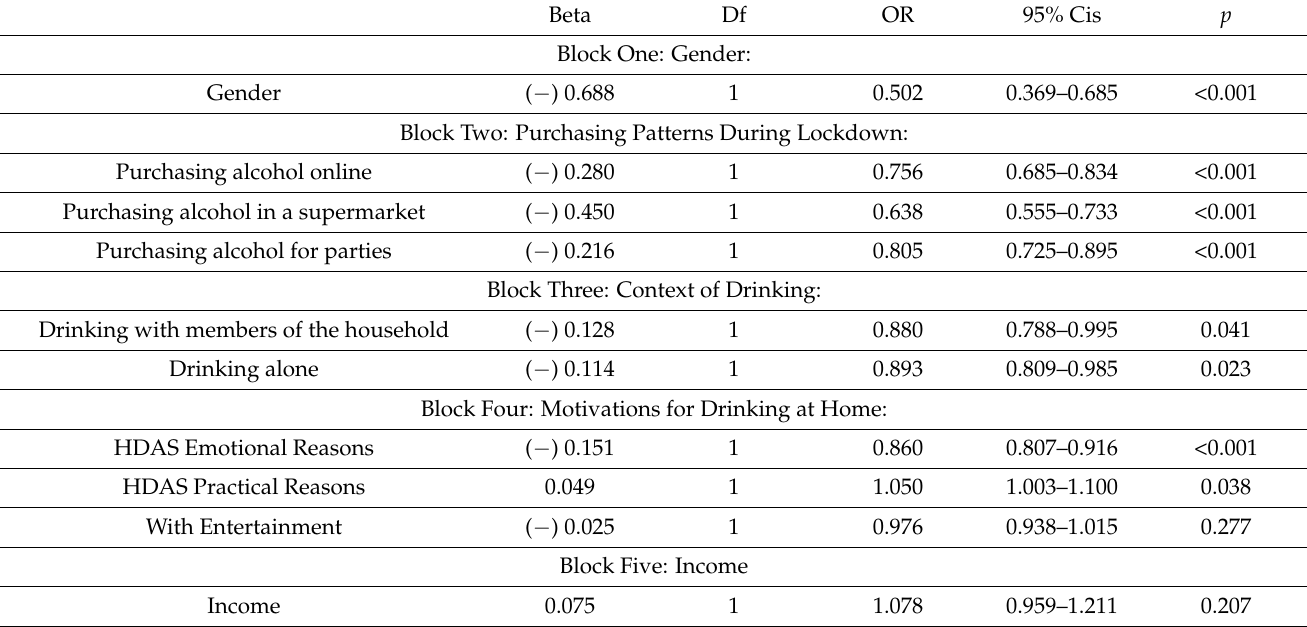
Table 5. Hierarchical regression for Regression 3 (AUDIT-C cut off 8 for both